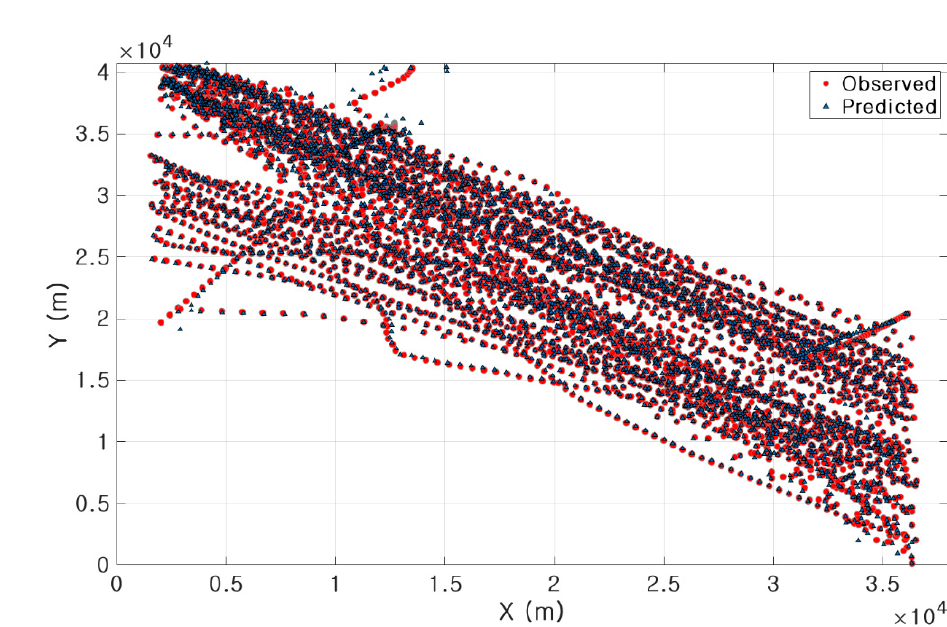
( j ) Error scatter plot for group B using LSTM.